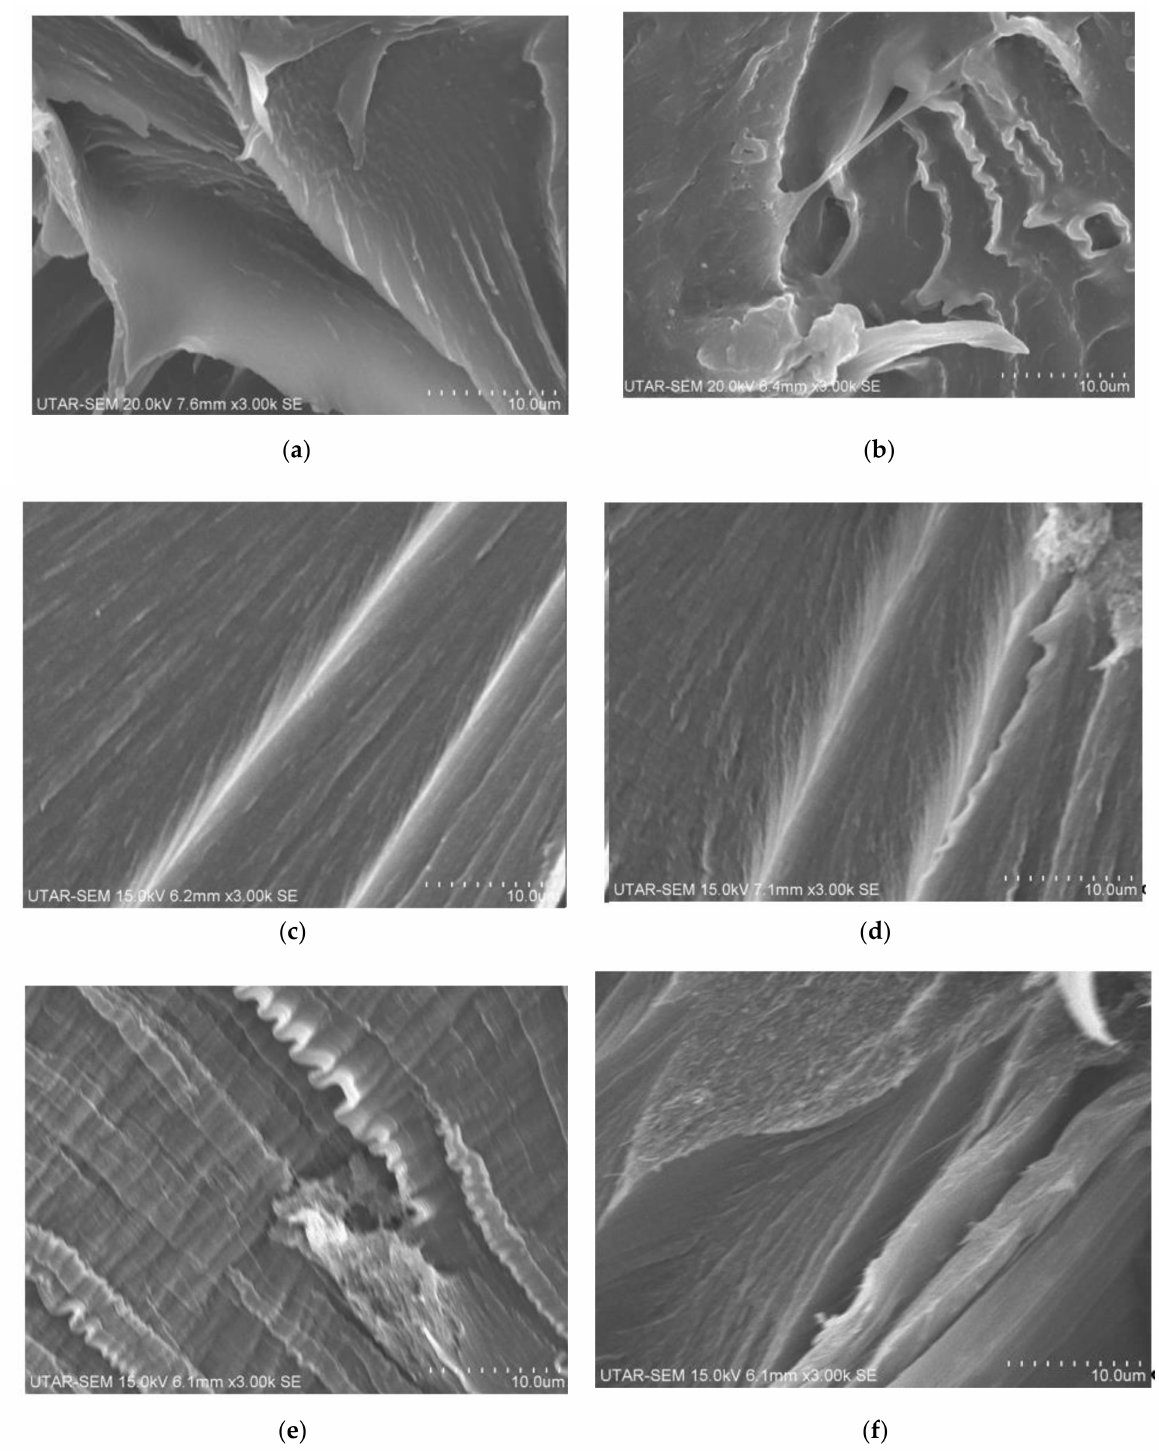
Figure 5. SEM micrographs of non-irradiated PVOH/CNT nanocomposites added with ( a ) 0.5 phr CNT, ( b ) 2.0 phr CNT, 10 kGy irradiated PVOH/CNT nanocomposites added with ( c ) 0.5 phr CNT, ( d ) 2.0 phr CNT, 30 kGy irradiated PVOH/CNT nanocomposites added with ( e ) 0.5 phr CNT and ( f ) 2.0 phr